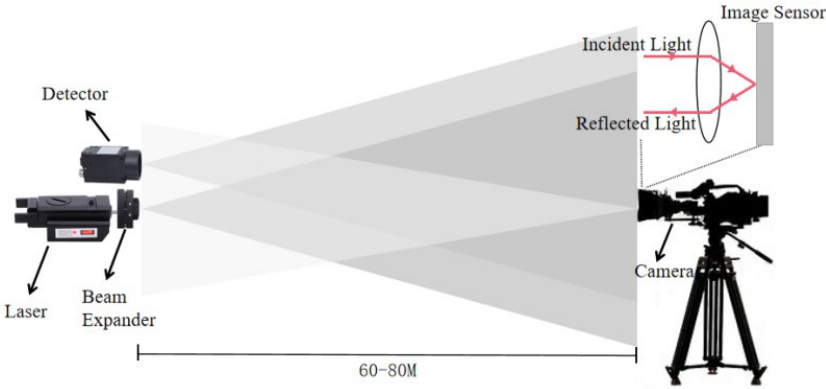
Figure 1. The data acquisition process of photoelectric target laser active imaging detection system. During image acquisition, the laser and detector were controlled by synchronous triggers. The detector acquired images every time the laser changed its operating state, and the detector’s operating frequency was twice that of the laser, ensuring smooth acquisition of active and passive